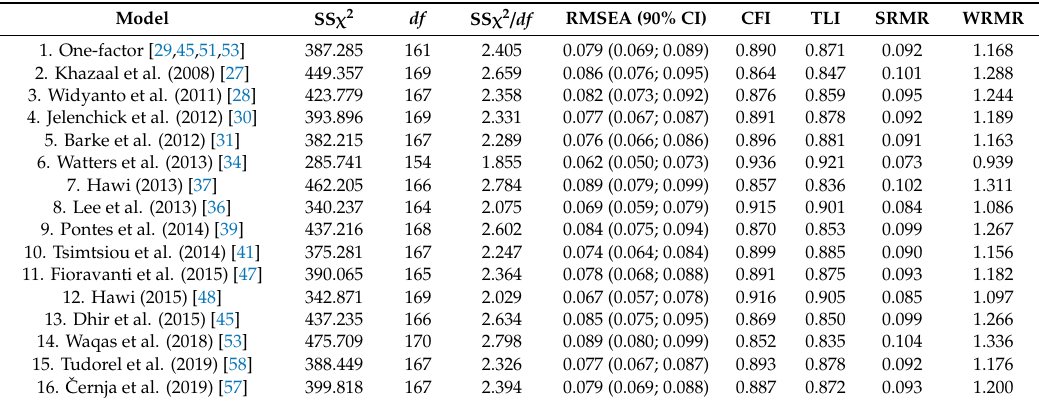
Table 4. Confirmatory factor analysis for the